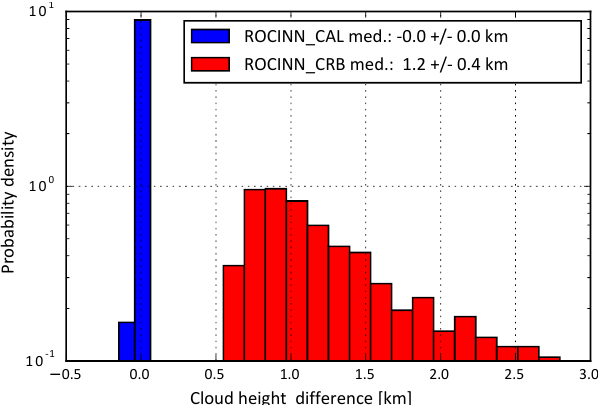
Figure 3. Histogram of the absolute differences between the sim- ulated spectra and the cloud height retrievals from ROCINN_CAL and